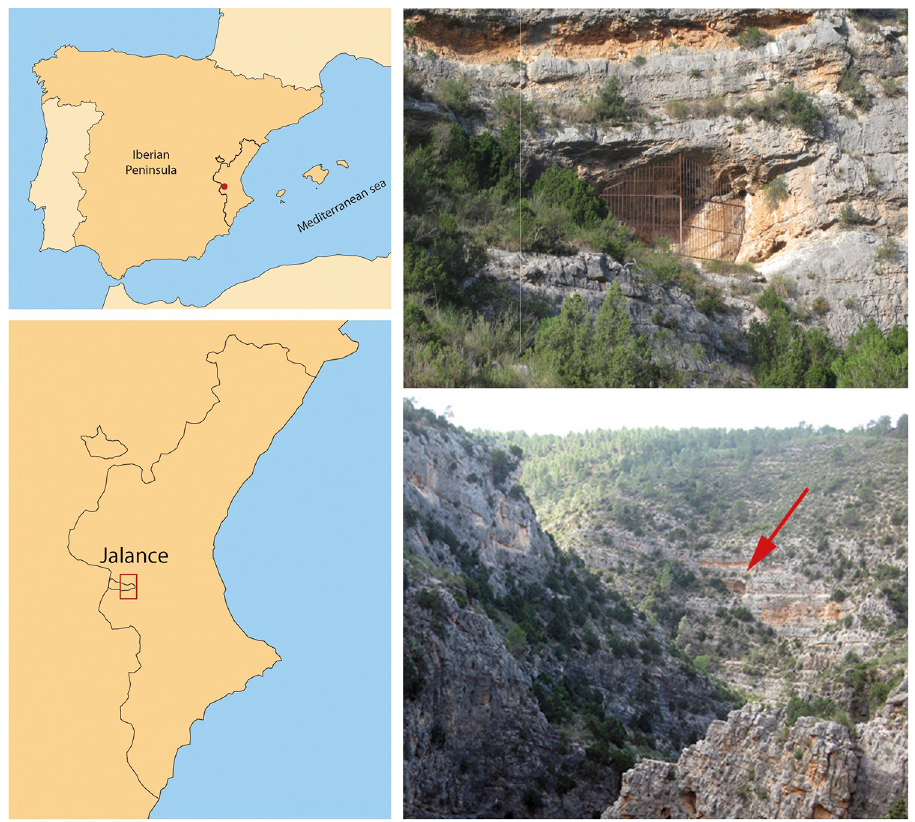
Fig 1. Geographical location of el Carche site (Jalance, Spain) and photographs of the site and the surroundings. Maps derived from ME500raster 2011–2012 CC-BY 4.0 ign.es.